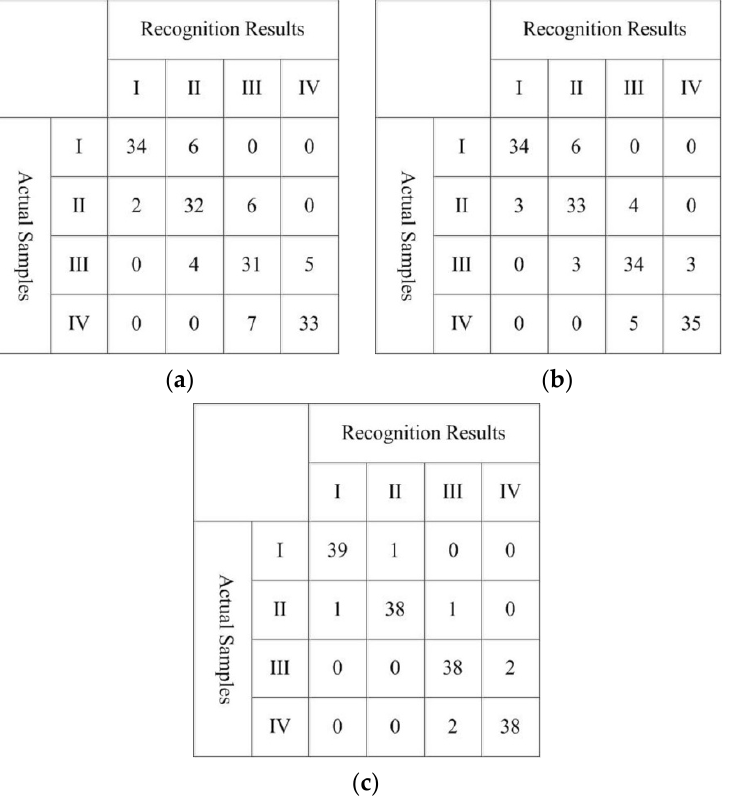
Figure 8. Confusion matrices of the recognition results using RGB, HSI, and fused features: ( a ) recognition using RGB features; ( b ) recognition using HSI features; ( c ) recognition using fused features.